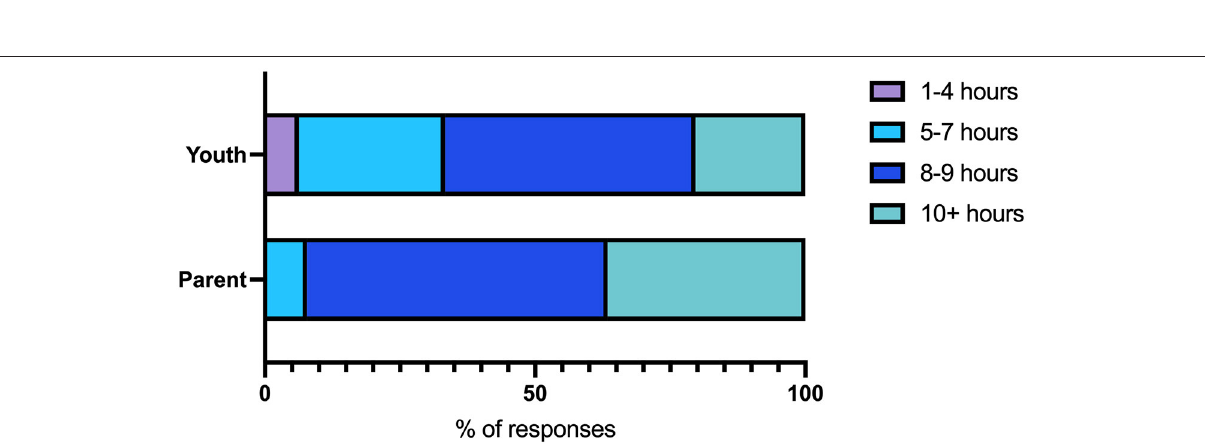
Frontiers in Pediatrics |